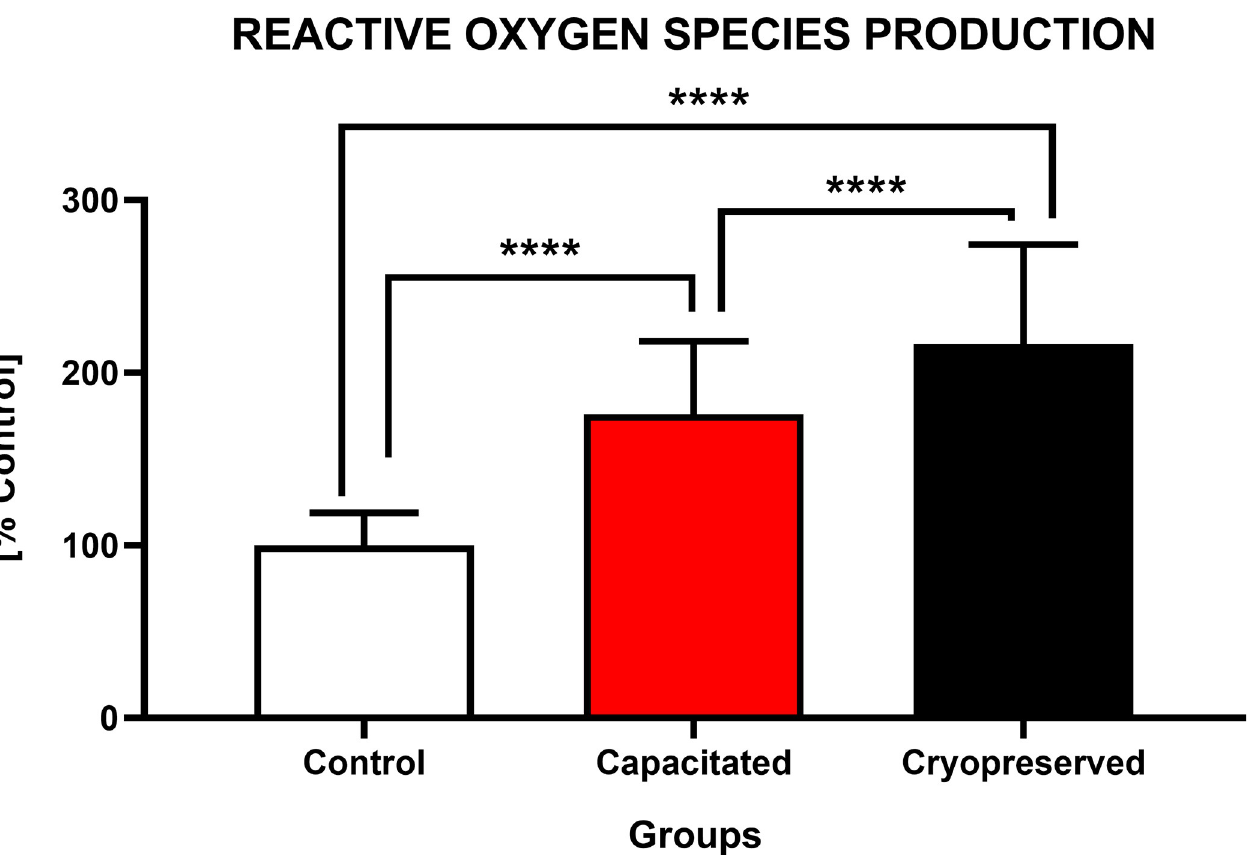
Fig 10. Intracellular ROS production of non-capacitated, in vitro capacitated and cryopreserved bovine spermatozoa. Each bar represented the concentration of ROS (%) between the groups ( ± SD). The level of significance was set at � P < 0.05; �� P < 0.01; ��� P < 0.001; ���� P < 0.0001.